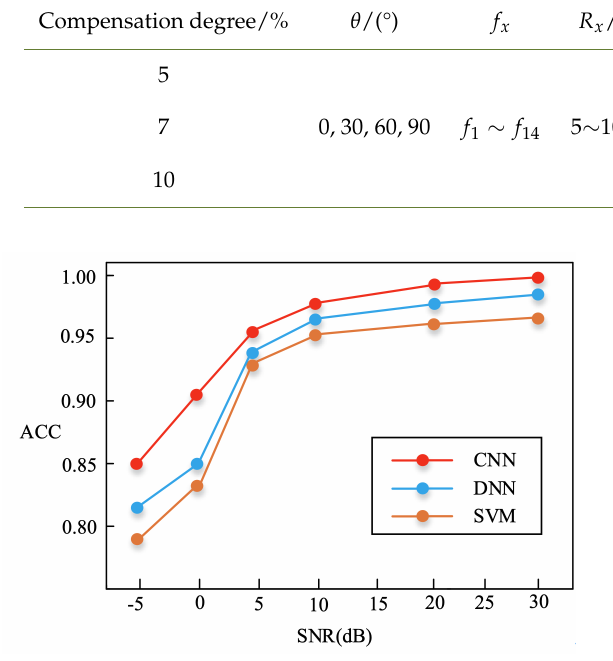
Table 9. Testing results of different compensation degree Compensation degree/%